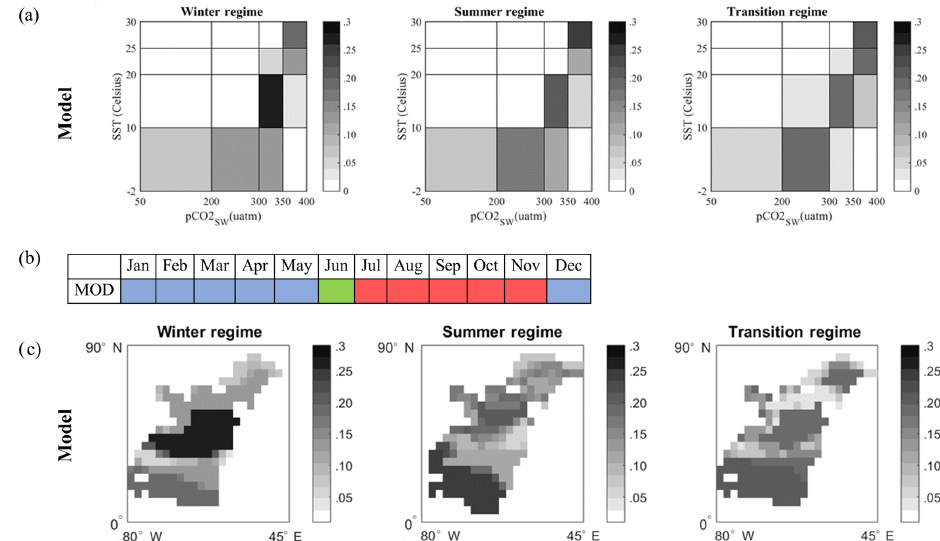
Figure 7. (a) Ocean carbon states (regimes) in the North Atlantic from the GISS model output. (b) Monthly attribution of each ocean carbon regime. Temporal attribution is based on the distance of each monthly 2-D histogram to the centroid of each cluster. Blue denotes the cold month regime (winter regime), red the warm months (summer regime) and green the transition regime (only June), since this is more a mix of the other two. (c) Regional attribution of each regime depicted in (a) . The frequencies of occurrence of each bin (value pair) in the clusters of (a) are mapped onto the North Atlantic